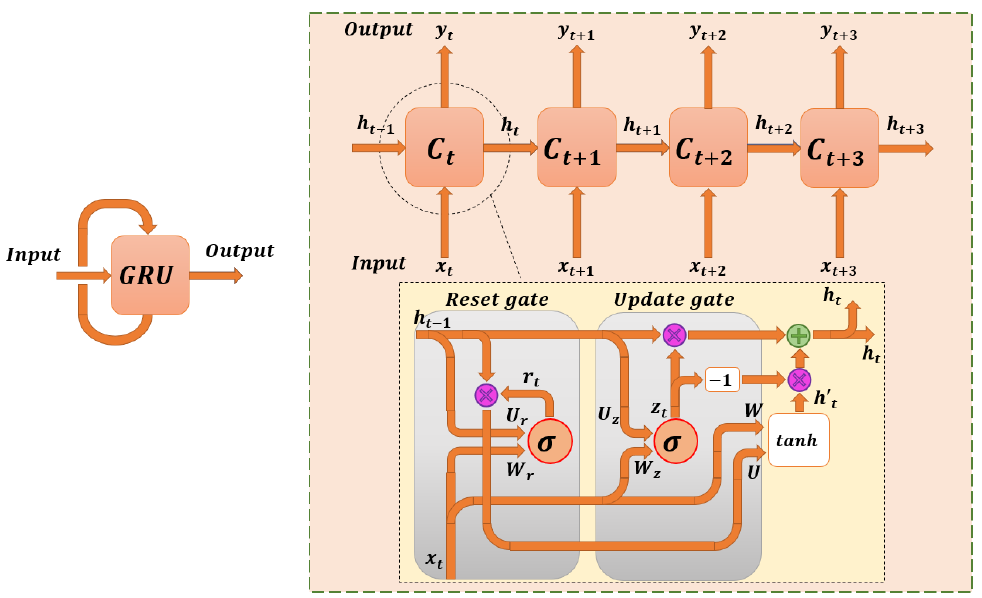
Figure 6. Generic schema of the content of a GRU neural network